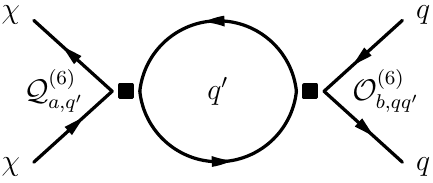
Figure 2 . A generic Feynman diagram with a double insertion of dimension-six operators, leading to the mixing into dimension-eight